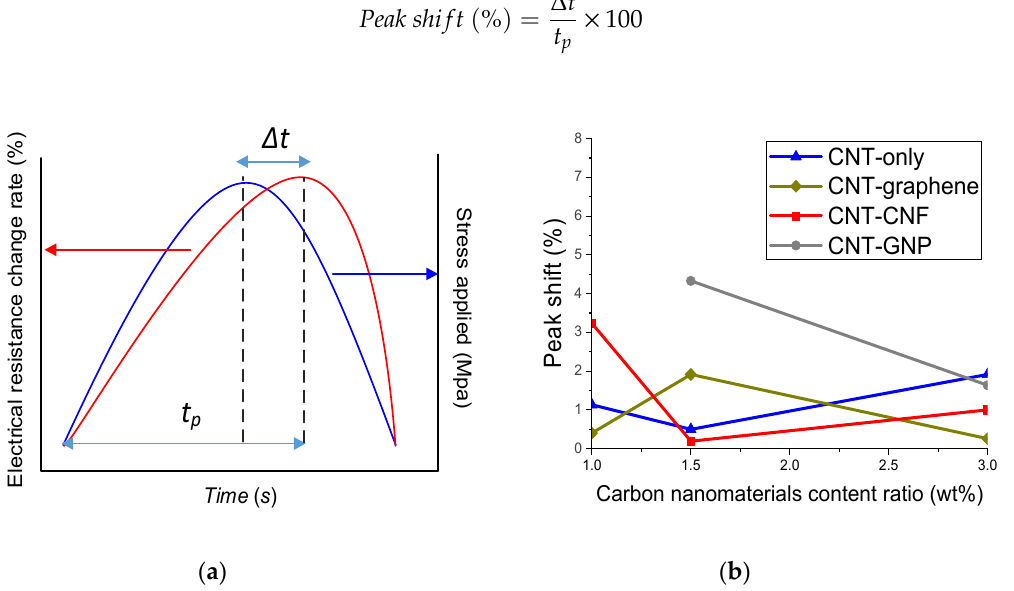
Figure 11. ( a ) Illustrative descriptions of peak shift, which is expressed as a percentage obtained by dividing the time interval of the resistant peak and the applied stress peak ( Δ t ) by the time difference ( t p ) between the initiating point and the peak point of the electrical resistance change rate curve, ( b ) peak shift values derived from the epoxy-based composites incorporating CNT-only, CNT–graphene, CNT–CNF, or CNT–GNP.